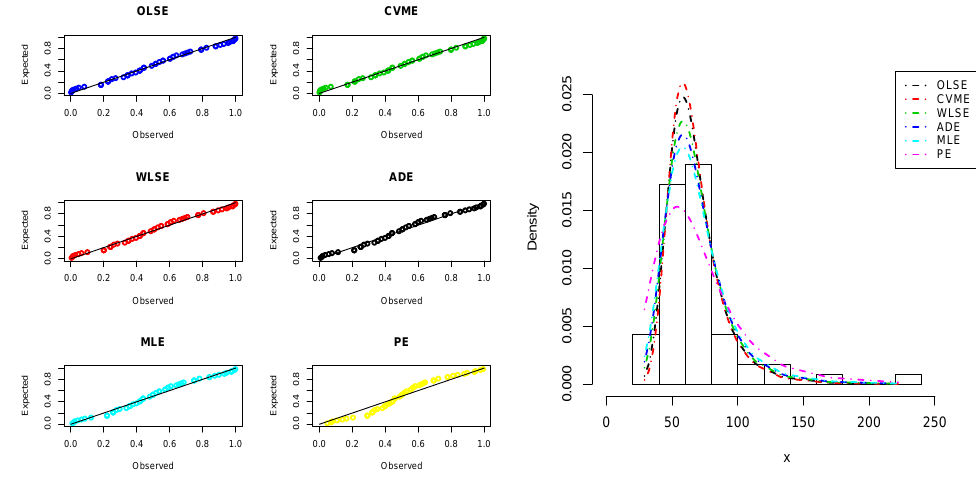
Figure 7. The P–P plots and histogram of insurance data with the fitted APExE density for estimation